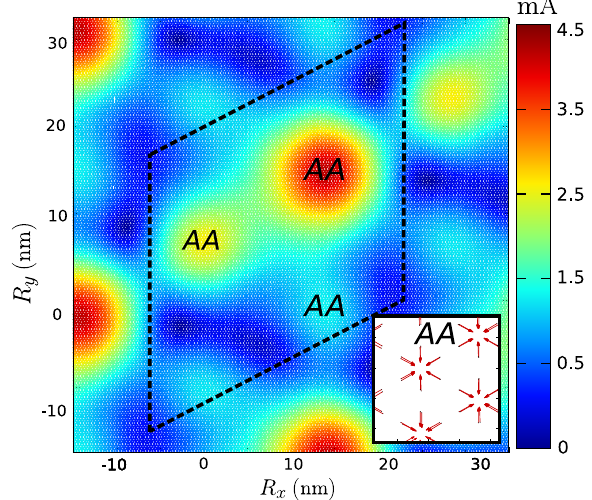
FIG. 10. Atomic displacements on one of the two layers corresponding to multicomponent deformation obtained combin- ing moir´e JT phonons at three inequivalent M points. The mean deformation is 1.7 mÅ and leads to the DOS in Fig. 11. The intensity of displacement is encoded in colors. The inset shows an enlargement of one of the AA regions when both layers are considered. The unit cell, denoted by a black dashed line, is 4 times larger than the original one.